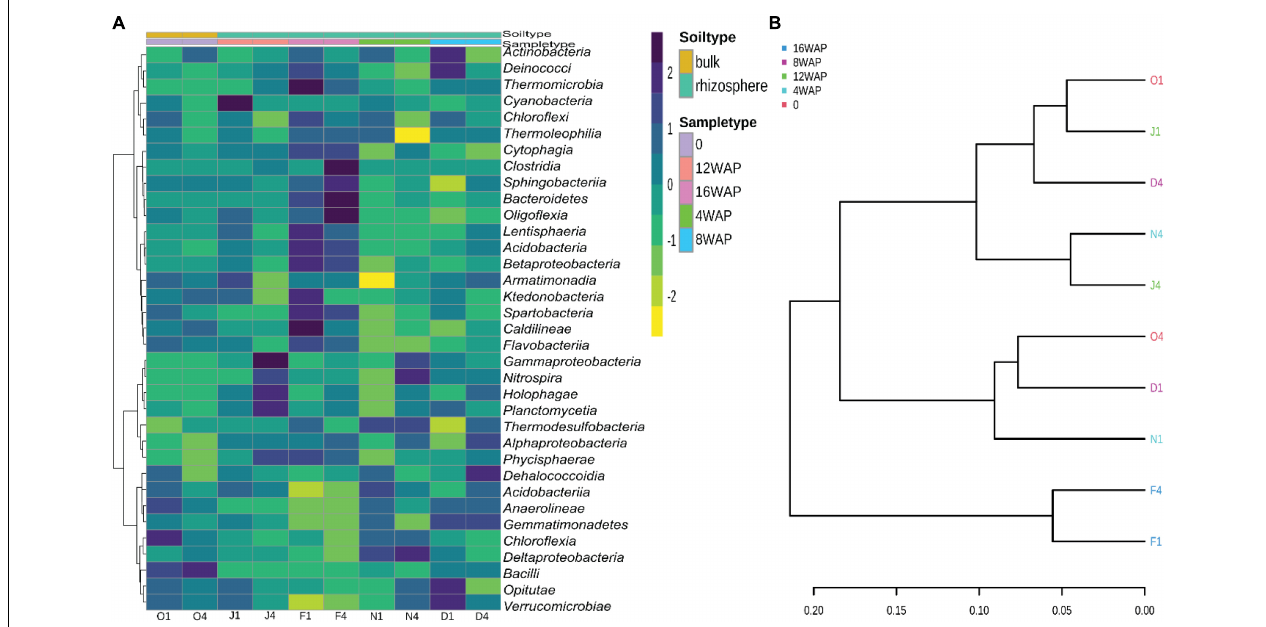
FIGURE 4 | (A) Heatmap of the bacterial biota in the bulk and rhizosphere soil at the different developmental stages at the class level. (B) Phylogenetic tree showing the relationship between the bulk soil and rhizosphere soil samples at the class